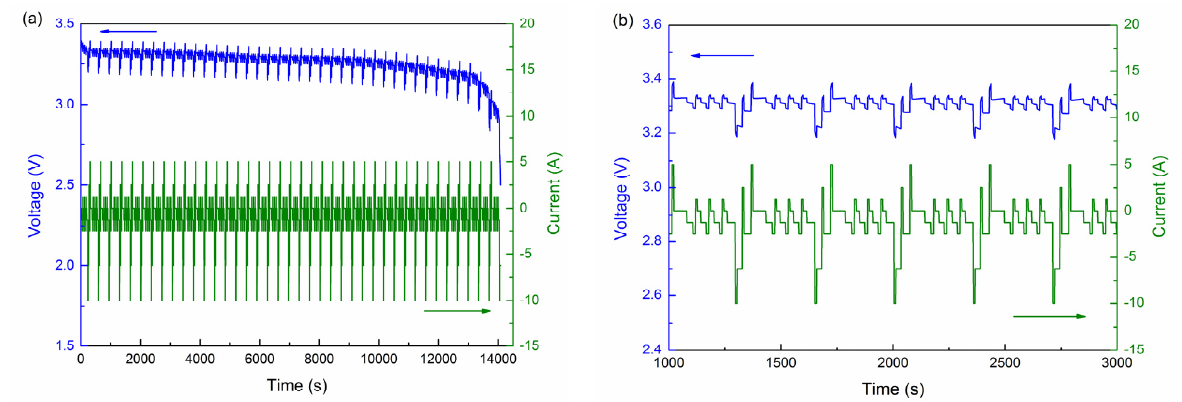
Figure 6. DST loading profiles at 40 °C: ( a ) voltage and current vs. time profiles and ( b ) enlarged version of ( a